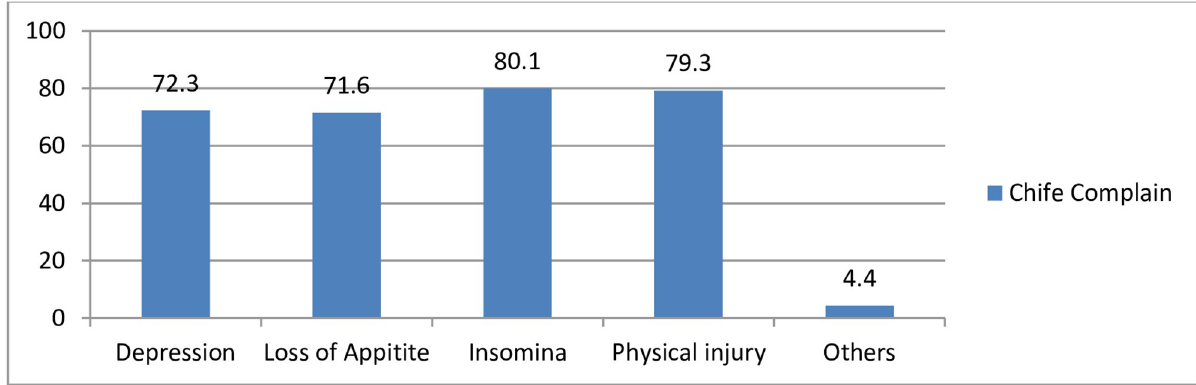
Fig 4. Common chief complains victims claimed in the health care provision in Northeast Ethiopia, 2022 (n = 271).